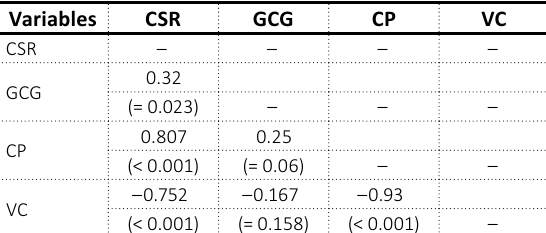
Table 9. Total effect and p